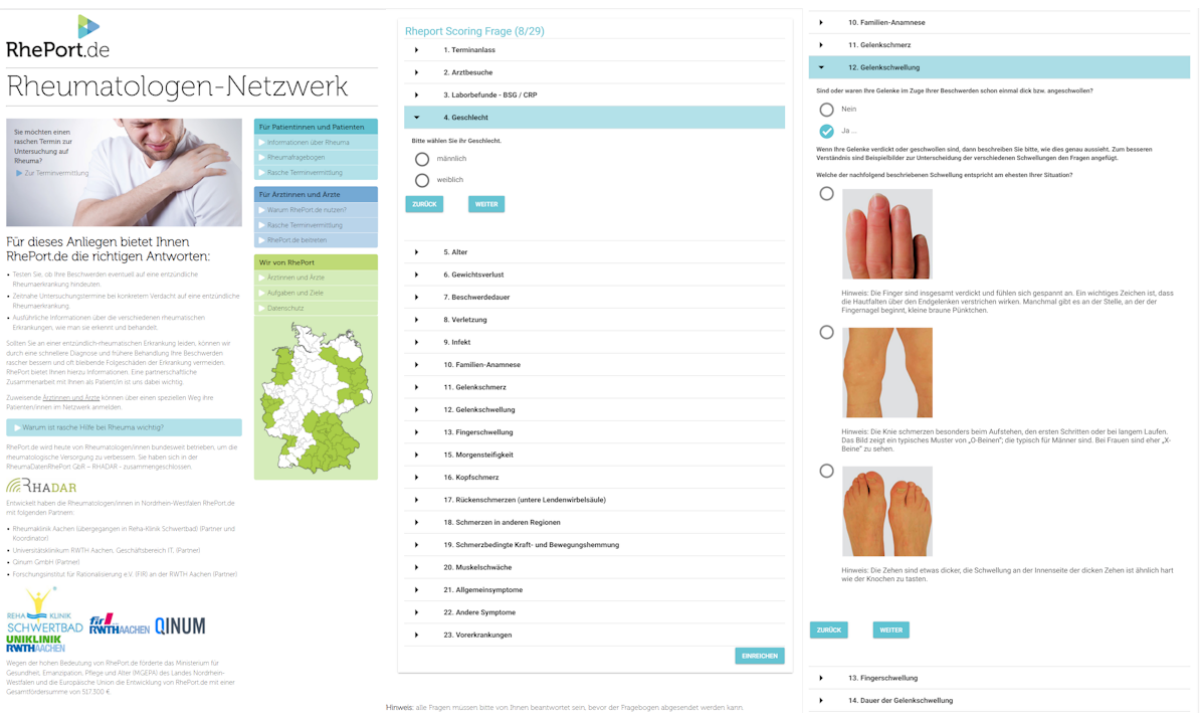
Figure 2. Screenshots of